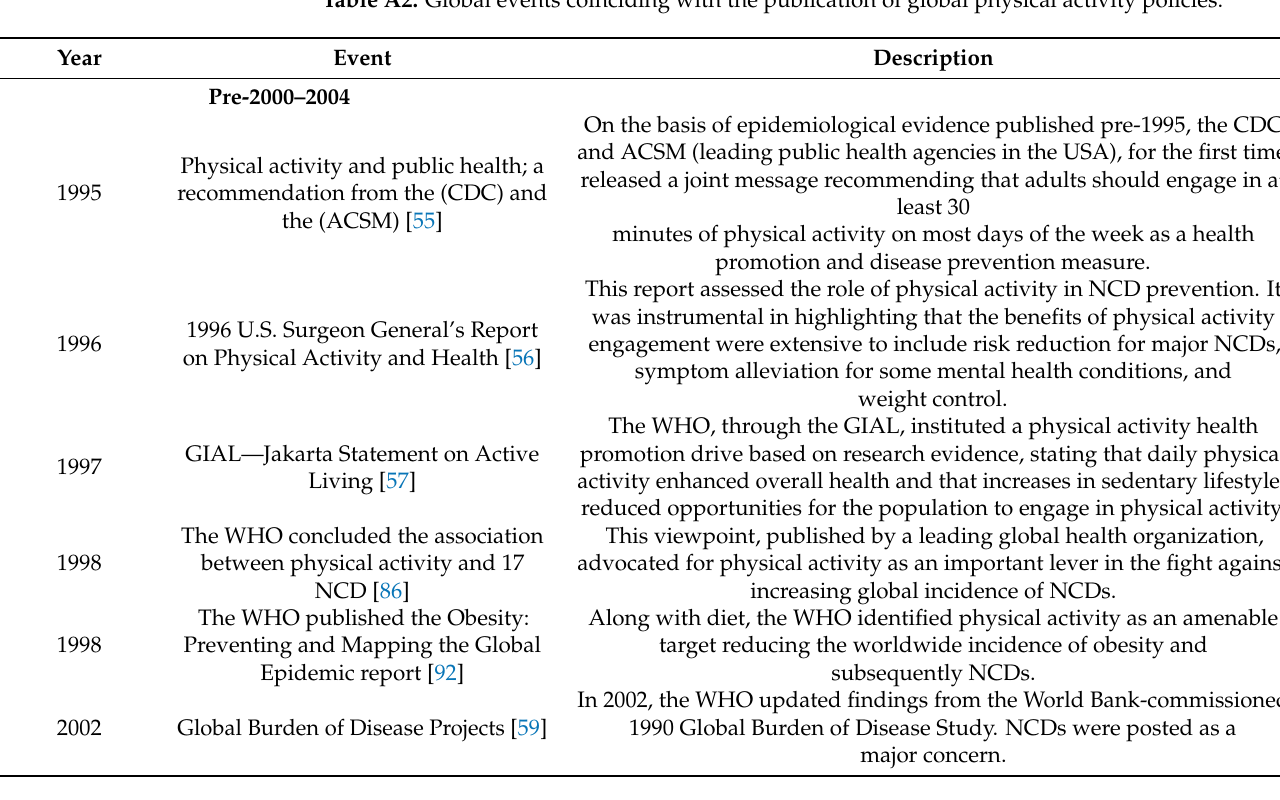
Table A2. Global events coinciding with the publication of global physical activity